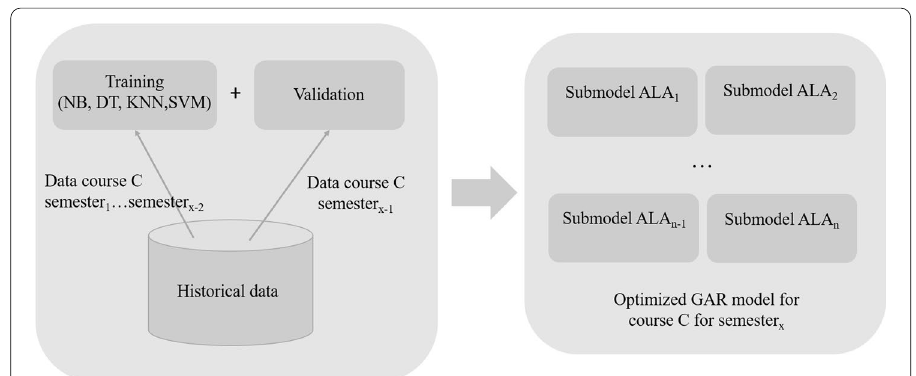
Fig. 1 Workflow for obtaining the optimized GAR model for a course C